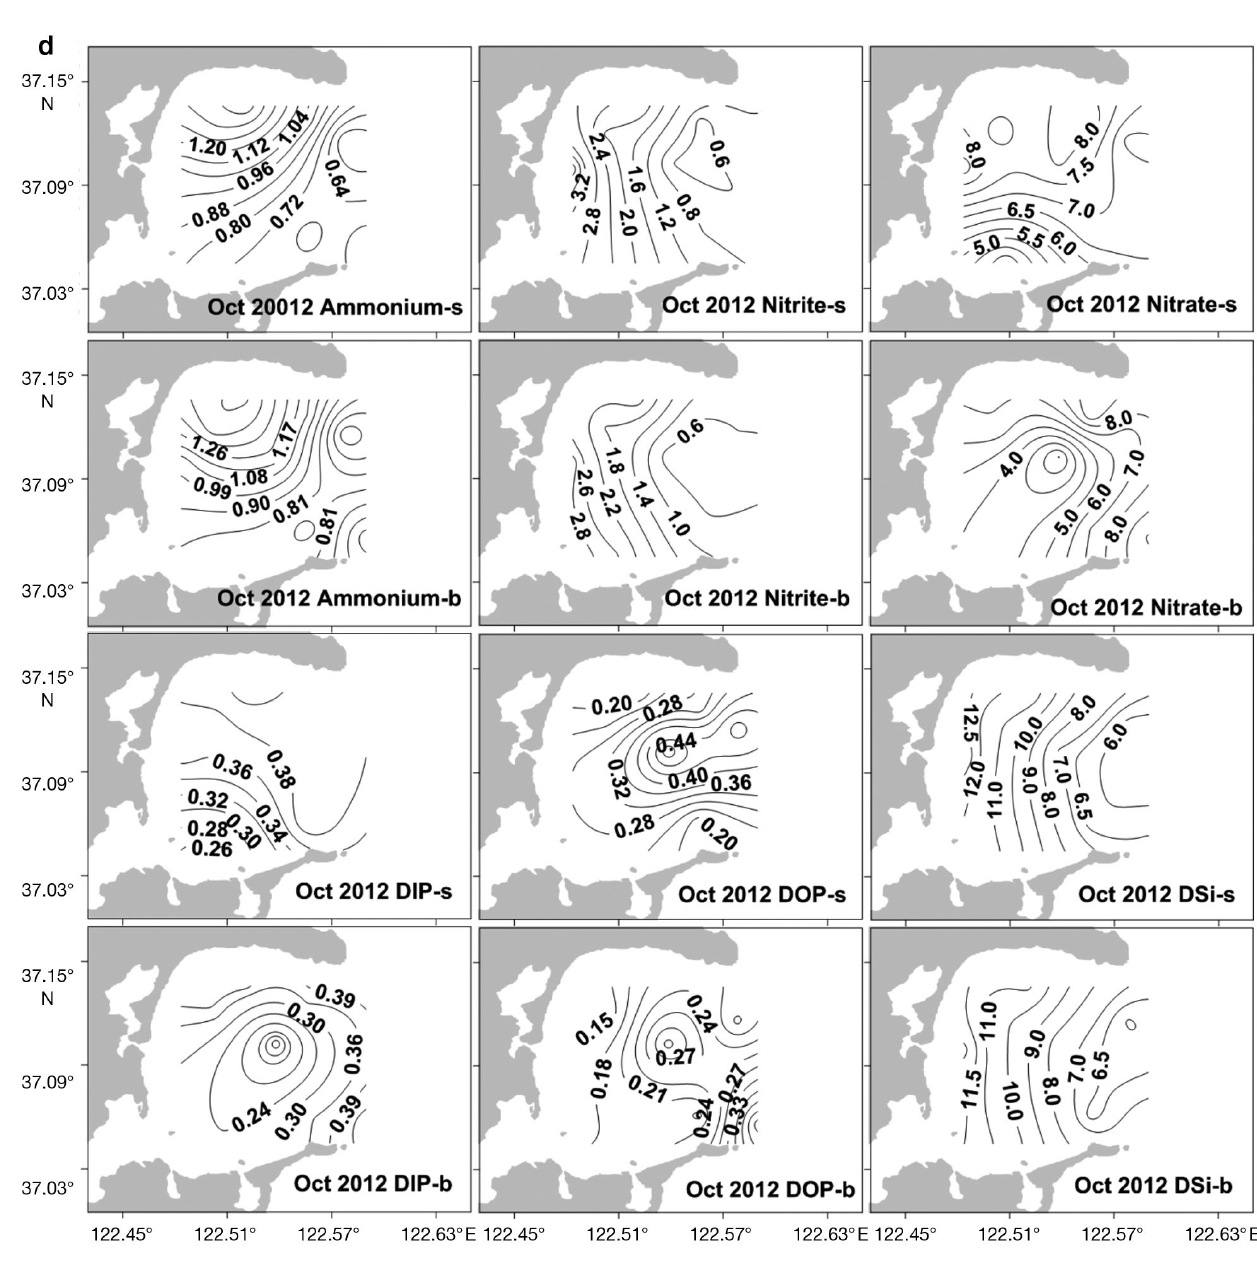
In the entire bay, NO 3− accounted for 66−92% of DIN. DON was the dominant species of TDN, which represented 53−81% of TDN in the water column, and DOP represented 35−67% of TDP. The molar ratios of DIN:PO 43− ranged from 20 to 62 and 17 to 46 in surface and bottom waters, respectively. The aver- age DSi:DIN ratio in surface and bottom waters was comparable and significantly lower than the Redfield ratio. The results suggest that phosphorus may be a limiting element for phytoplankton growth in